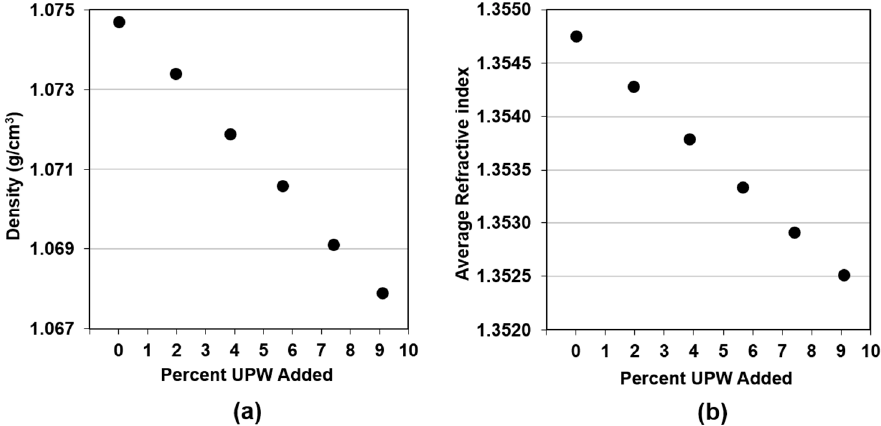
Figure 1. Calibration results as a function of amount of ultrapurified water (UPW) added for the Fujimi PL-7106 regarding ( a ) density and ( b ) average Refractive Index.